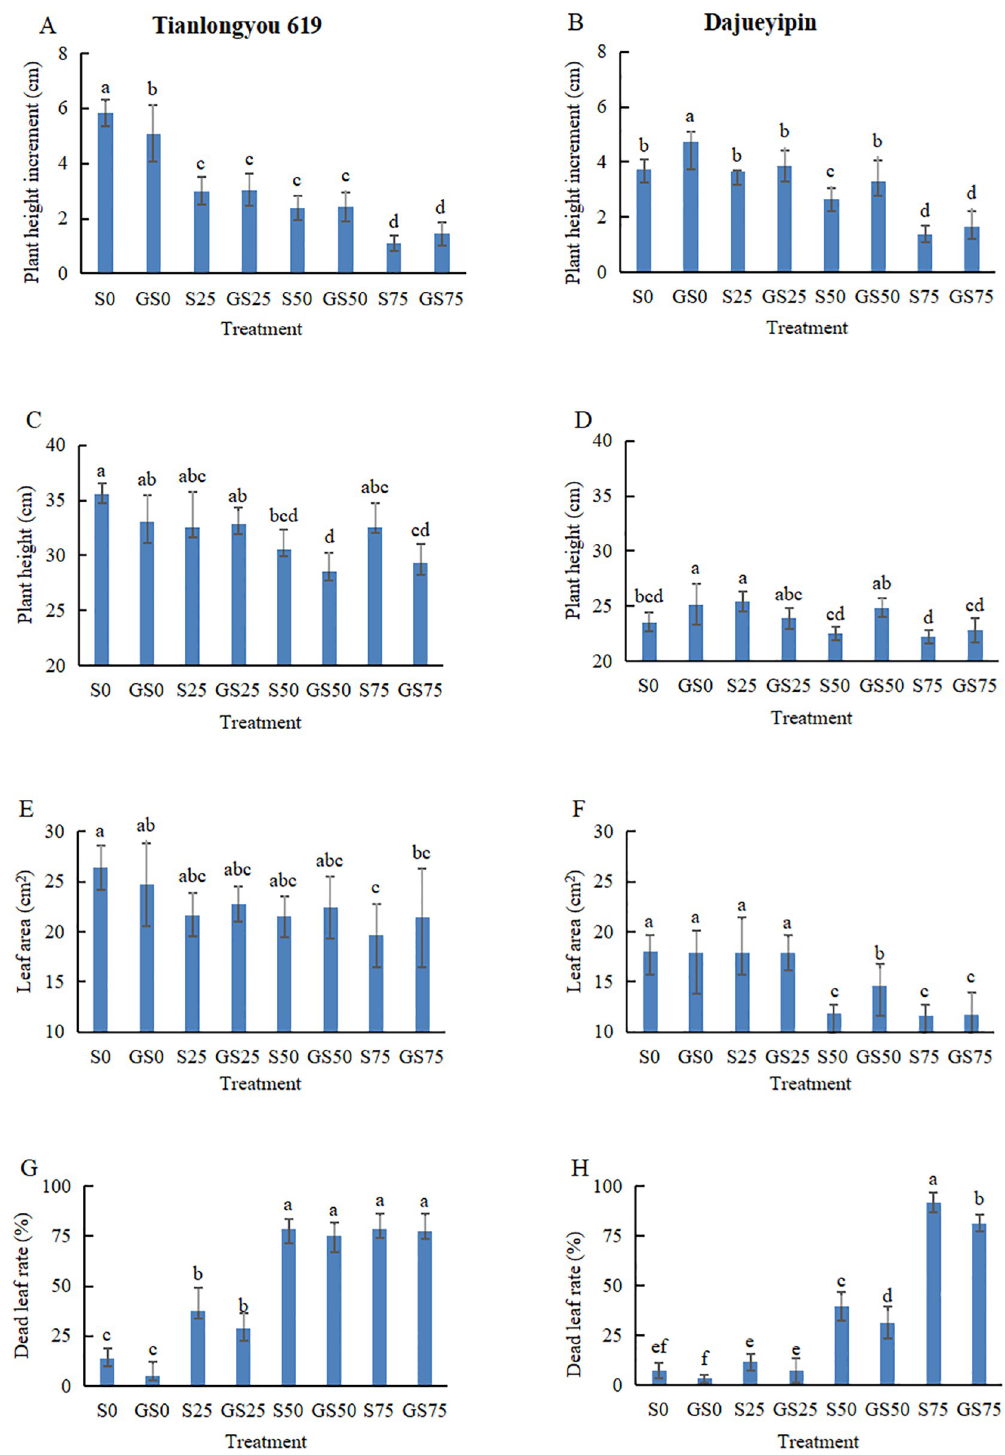
Fig 2. Assessment of seedling growth on two rice varieties under different salt or/and GABA treatments.